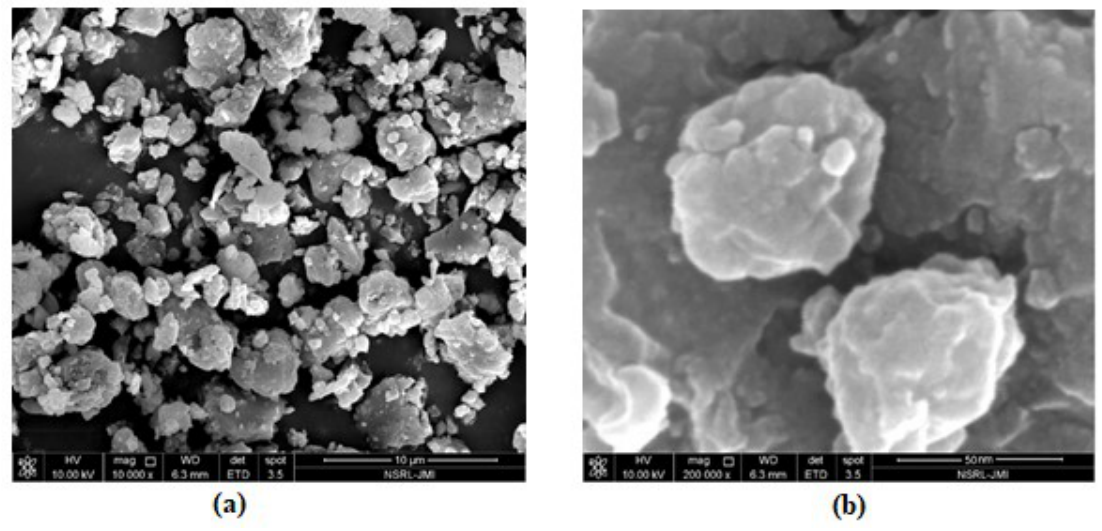
Figure 2. TEM images of spectrum of N-methyl butyl imidazolium bromide copper oxide nanocomposite: ( a ) at 10,000 and ( b ) 2,00,000 magnifications (ranging from 50 to 99.5 nm).